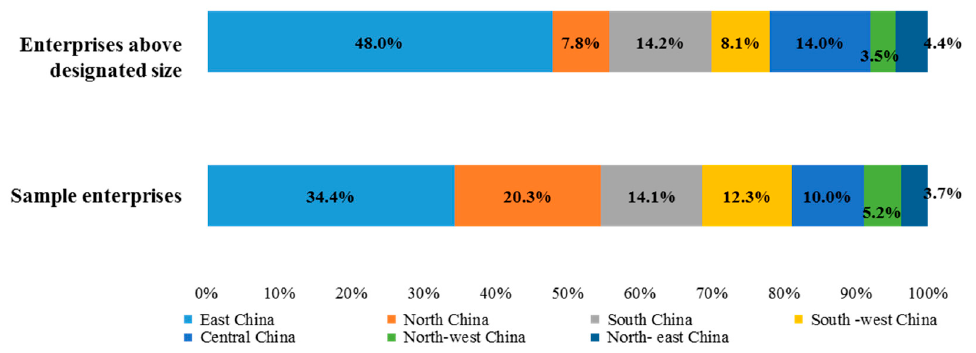
Figure 7. Region representativeness of sample enterprises.